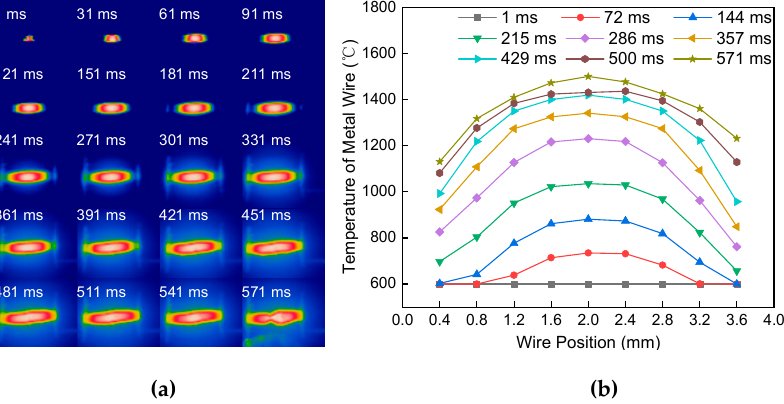
Figure 7. E ff ect of electrode distance on melting of a single metal wire. ( a ) Melting process. Figure 7. Effect of electrode distance on melting of a single metal wire. (a) Melting process. (b) ( b ) Temperature distribution. Temperature distribution.